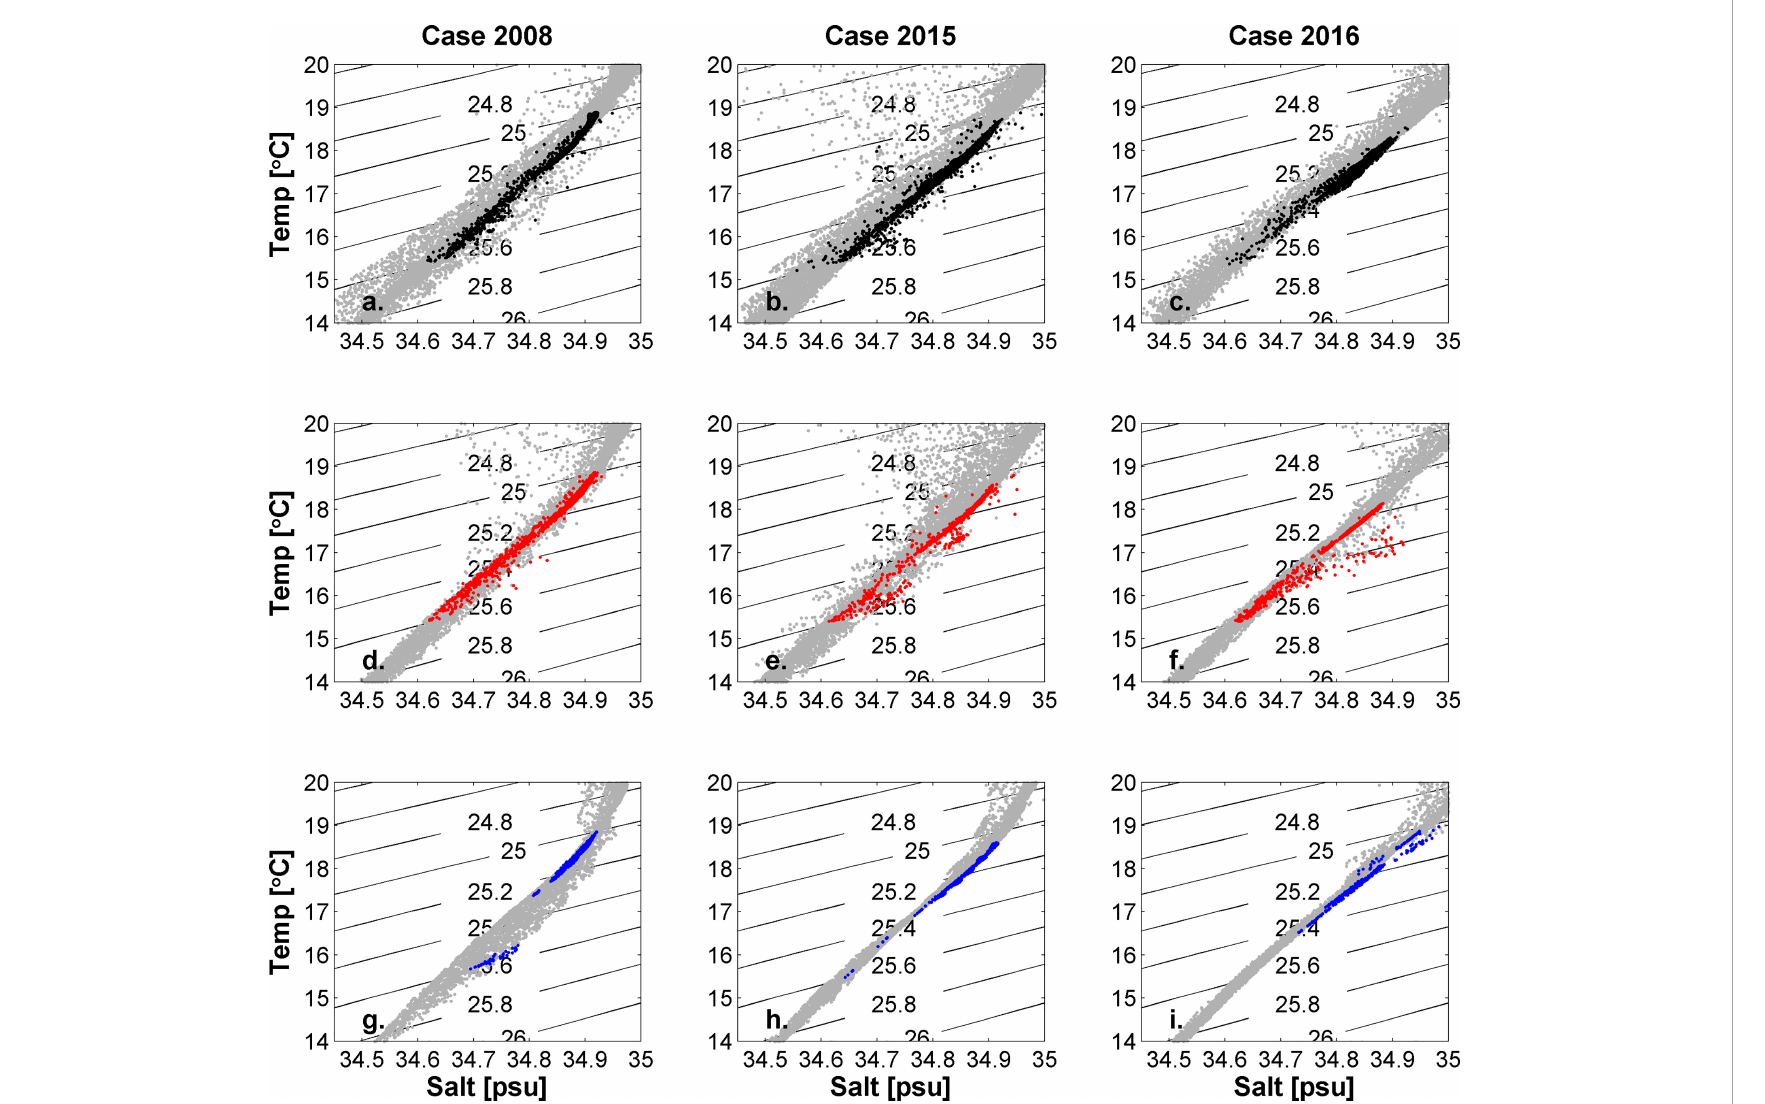
FIGURE 11 T-S plots of the low PV signal on the dates when the low PV signal was located in the 19° – 22°N, 122° – 125°E area: (A) 13 June 2008, (B) 22 Dec. 2015 and (C) 11 May 2016 (black dots); T-S plots on the dates the low PV signal was isolated and located in the 18° – 21°N, 118° – 120°E area: (D) 31 July 2008, (E) 11 Feb. 2016 and (F) 21 Aug. 2016 (red dots); and on the dates the low PV signal moved far westward in the 16° – 18° N, 113° – 115°E area: (G) 1 Nov. 2008, (H) 11 May 2016 and (I) 4 Dec. 2016 (blue dots). The gray dots present the waters in which the PV is higher than 2 (cid:1) 10 − 10 m − 1 · s − 1 above 600 m. The left/middle/right columns represent the 2008/2015/2016 cases,